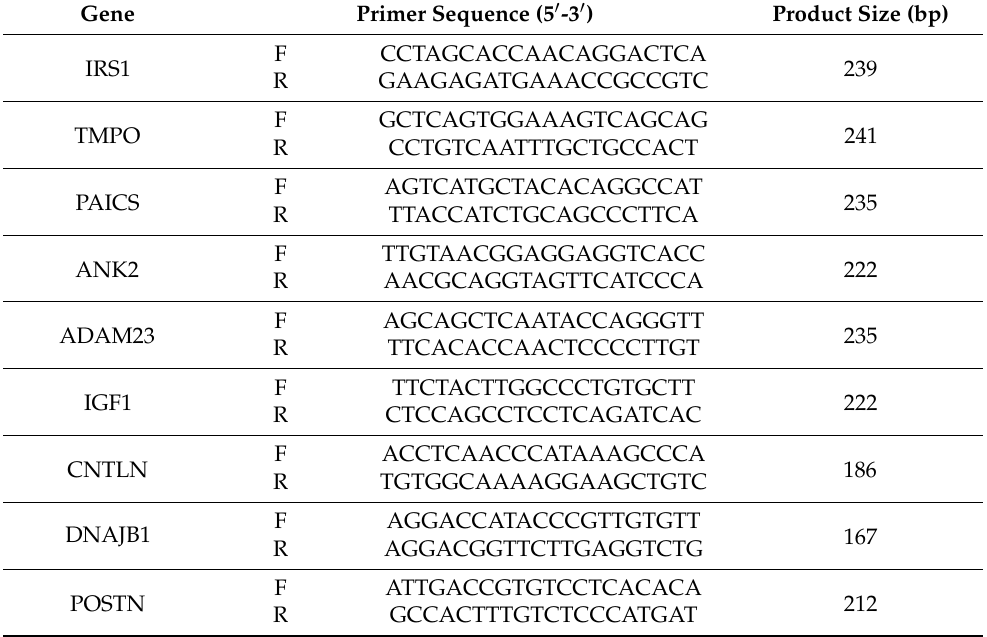
Table 1. Oligonucleotide sequences of primers used for RT-qPCR analysis.